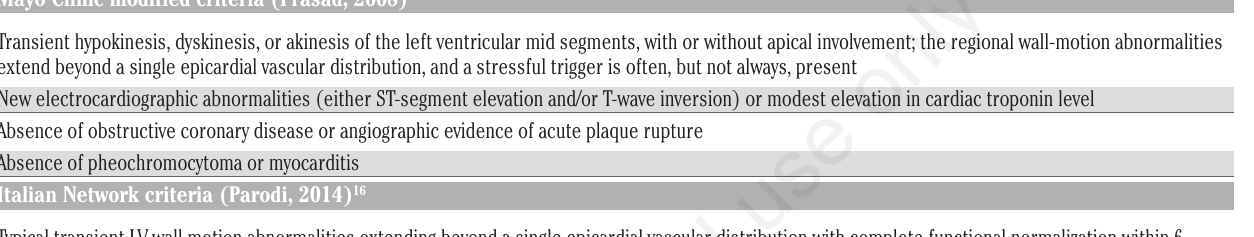
Table 1. Diagnostic criteria for Takotsubo syndrome. Mayo Clinic modified criteria (Prasad, 2008) 15